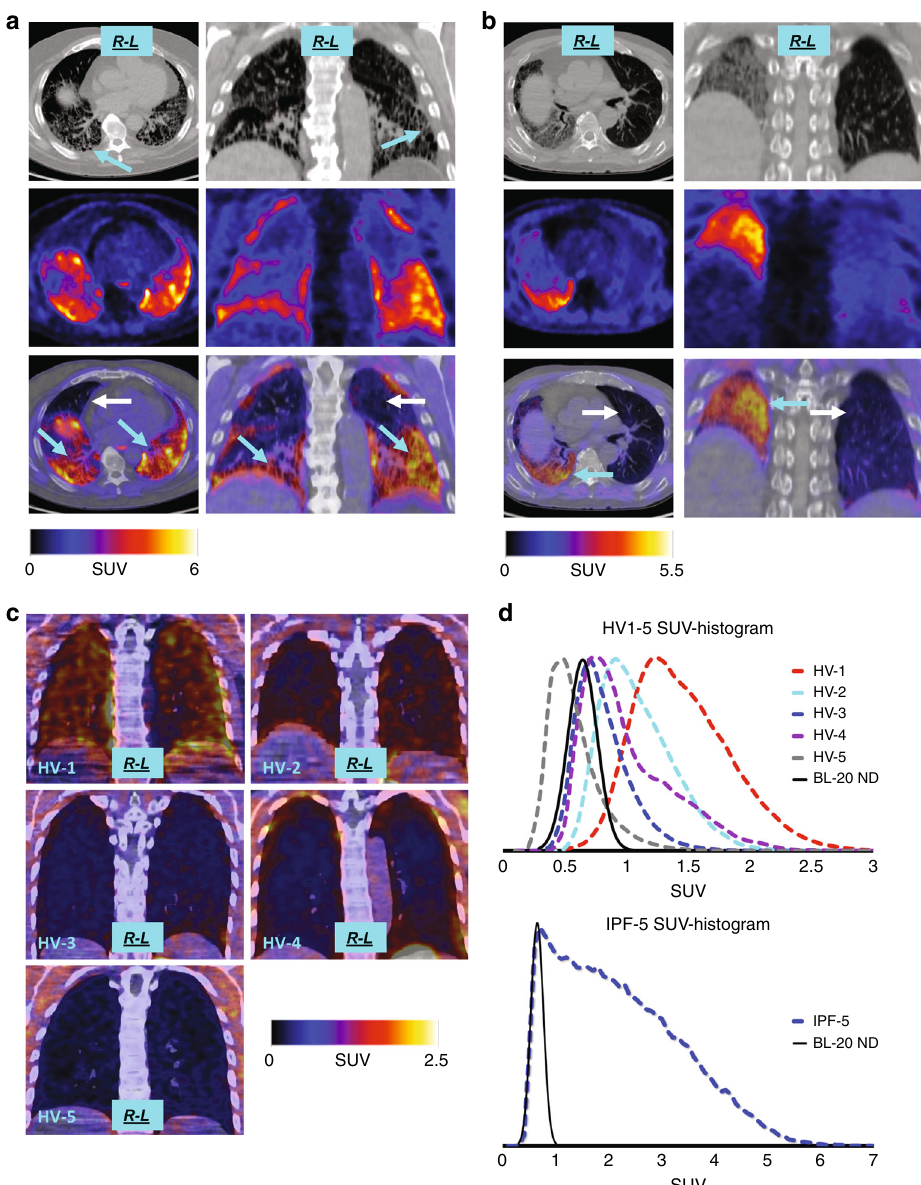
Fig. 6 [ 18 F]FP-R 0 1-MG-F2 PET imaging of lungs: IPF patients and healthy volunteers. a PET/CT images of IPF-5, a 72-year-old male IPF patient with a de fi nite-UIP pattern, as indicated by peripheral, basilar predominant reticulation and honeycombing (CT, top, cyan arrows). Correspondingly, the PET tracer is concentrated in regions of greatest fi brosis in the areas of high reticulation and honeycombing in the lung bases (PET, middle and PET/CT, bottom, cyan arrows). In contrast, relatively healthy regions of the upper and anterior lungs show low tracer accumulation (PET/CT, bottom, white arrows). b PET/CT images of a 72-year-old male IPF patient with a single transplanted (2016) left lung (white arrows), which is relatively devoid of the PET tracer. The fi brotic right lung (IPF) shows elevated PET tracer levels in areas that also correspond to the highly fi brosed regions demonstrated on CT (PET/CT, bottom, cyan arrows). c PET/CT images of the lungs of fi ve healthy volunteers, varying in age from 20- to 48-year old. The group demonstrated a range of lower [ 18 F]FP- R 0 1-MG-F2 accumulation in their lungs. d The dashed lines represent histograms of SUVs found within ROI contours of total lung. The upper histogram represents the healthy volunteers (HV-1 to HV-5). The lower histogram (dashed blue line) represents patient IPF-5 shown in panel A. For comparative purposes, the solid black curves in both (top and bottom graphs) represent baseline-20 SUV mean and normal distribution (BL-20 ND) derived from the two youngest healthy volunteers in their 20 s (HV-3 and the high degree of correlation between right and left lungs of FP-R 0 1-MG-F2 levels occurred in the two youngest volunteers, 20 healthy volunteers and IPF patients, their right lungs were (HV-3) and 26-year old (HV-5), where their total-lung compared to avoid the left lung transplant of IPF-4. A statistically SUV mean s = 0.76 ± 0.22 and 0.53 ± 0.20, respectively. For com- signi fi cant difference ( p = 0.0087) in PET-tracer level was found parative purposes, the relatively pristine young lungs in these two between the set of healthy right lungs (average SUV mean = 0.92 ± individuals served as an age-based SUV referential-baseline 0.33, n = 5) versus the diseased right lungs of IPF patients (baseline-20 SUV mean = 0.67 ± 0.12, and normal distribution) for comparison of all lung data reported in this study (average SUV mean = 2.04 ± 0.91, Fig. 7, n = 6). The lowest [ 18 F]